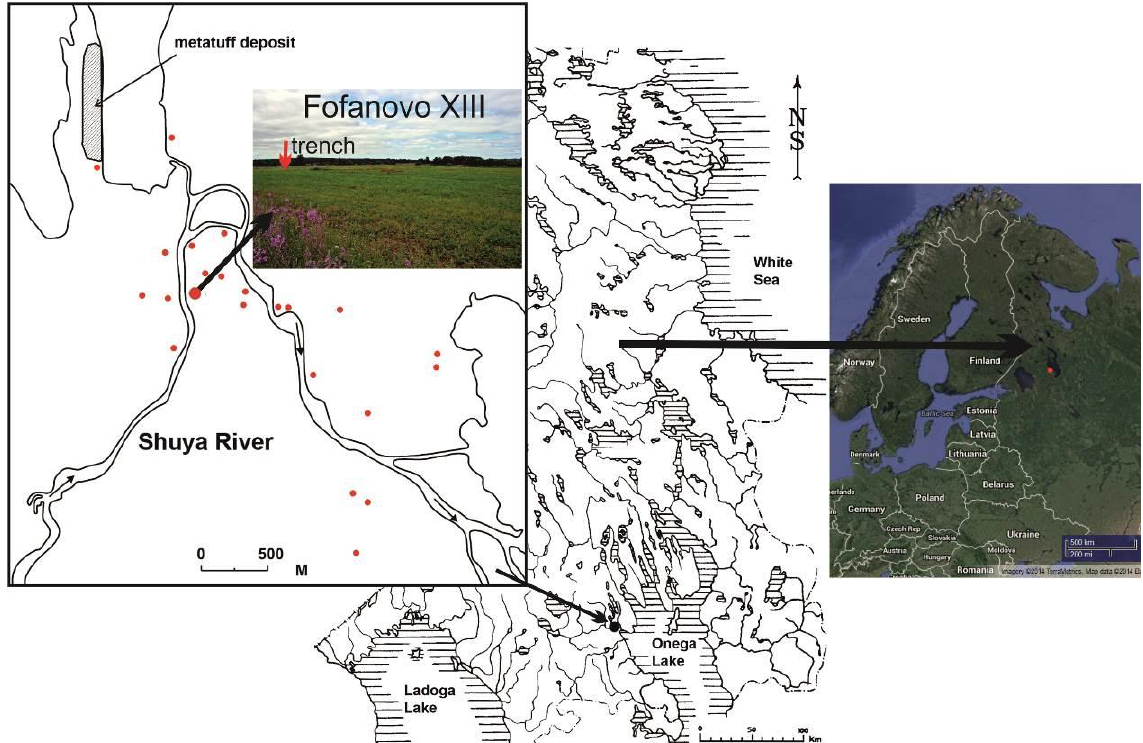
Figure 1. Location of workshop sites for making metatuff chopping tools of the Russian Karelian type in the outfall of Shuya River on the western coast of Onega lake. World Map data from Google